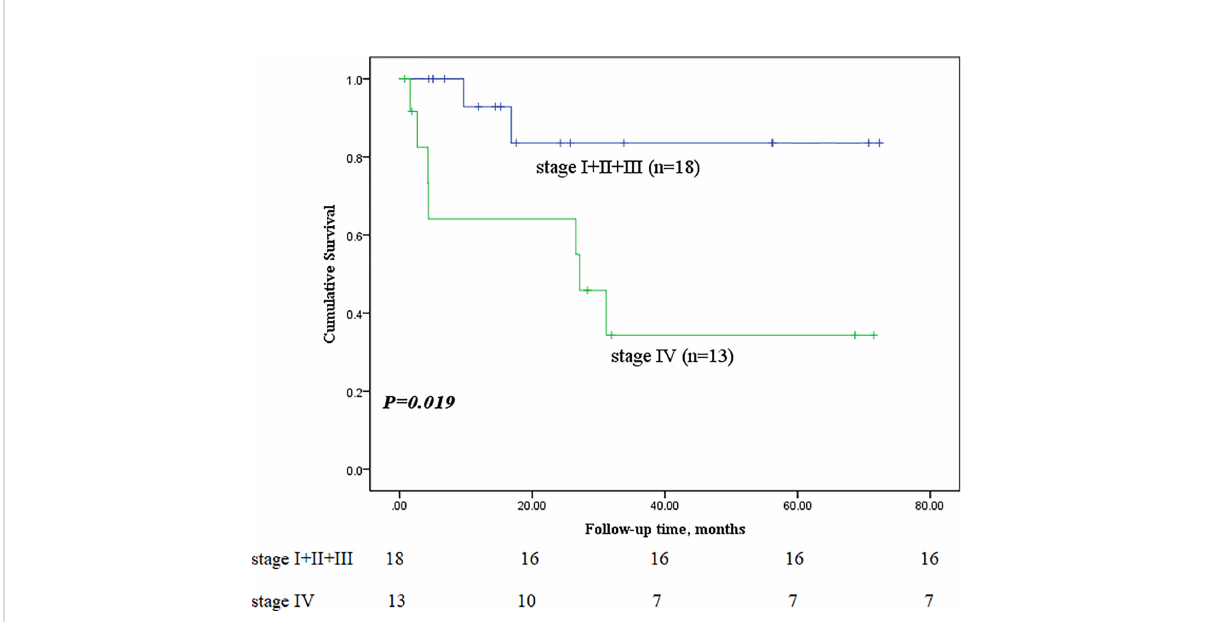
FIGURE 6 Comparison of primary outcomes between mucoepidermoid carcinoma patients with and without stage IV